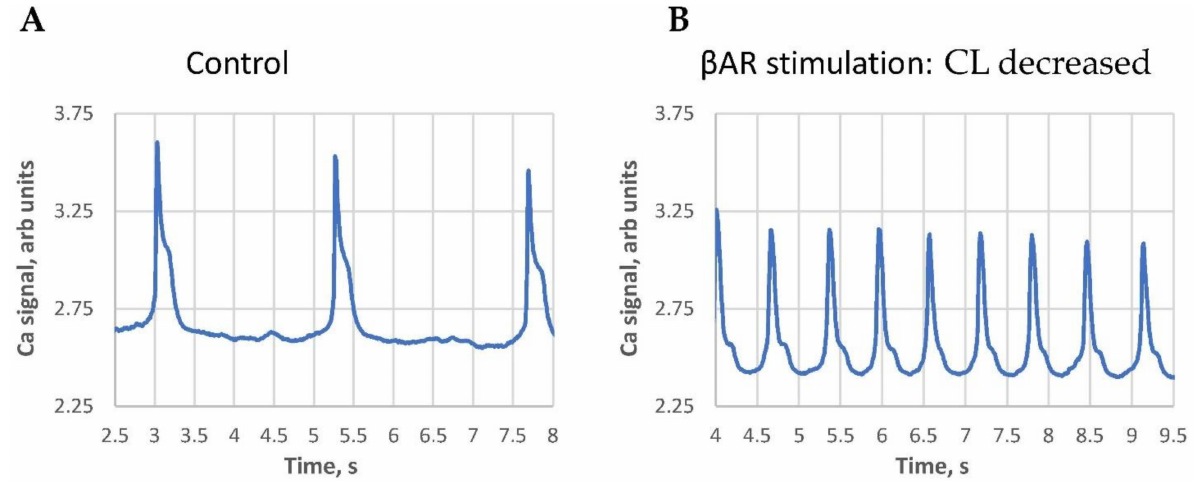
Figure 2. An example of the β AR stimulation effect in cells with extremely long AP-induced Ca transient cycle length (CL). ( A ): at the base line, i.e., an “almost dormant cell”. ( B ): β AR stimulation. Both traces have the same 5.5 s duration for a clear visual comparison. See also Videos S7 and S8 of cell Ca dynamics in the control and in the presence of β AR stimulation.